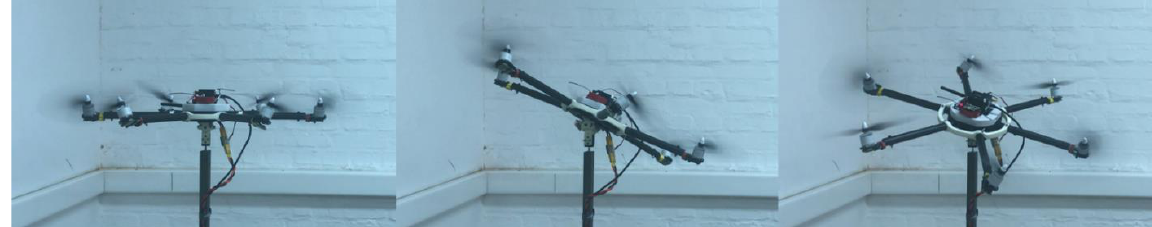
Figure 12. Experimental testing of attitude control on PTX6 for the case of reference state tracking.